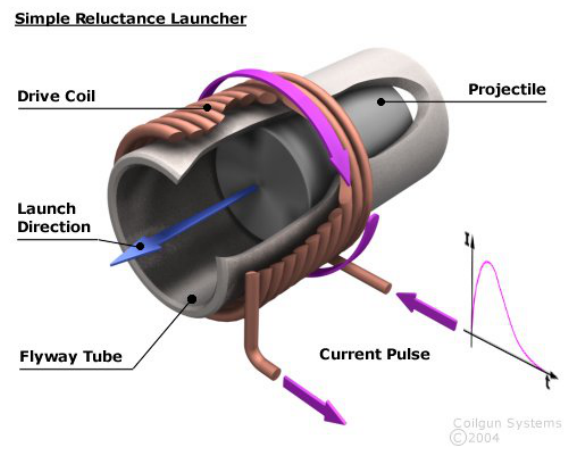
Figure 2. Coil gun